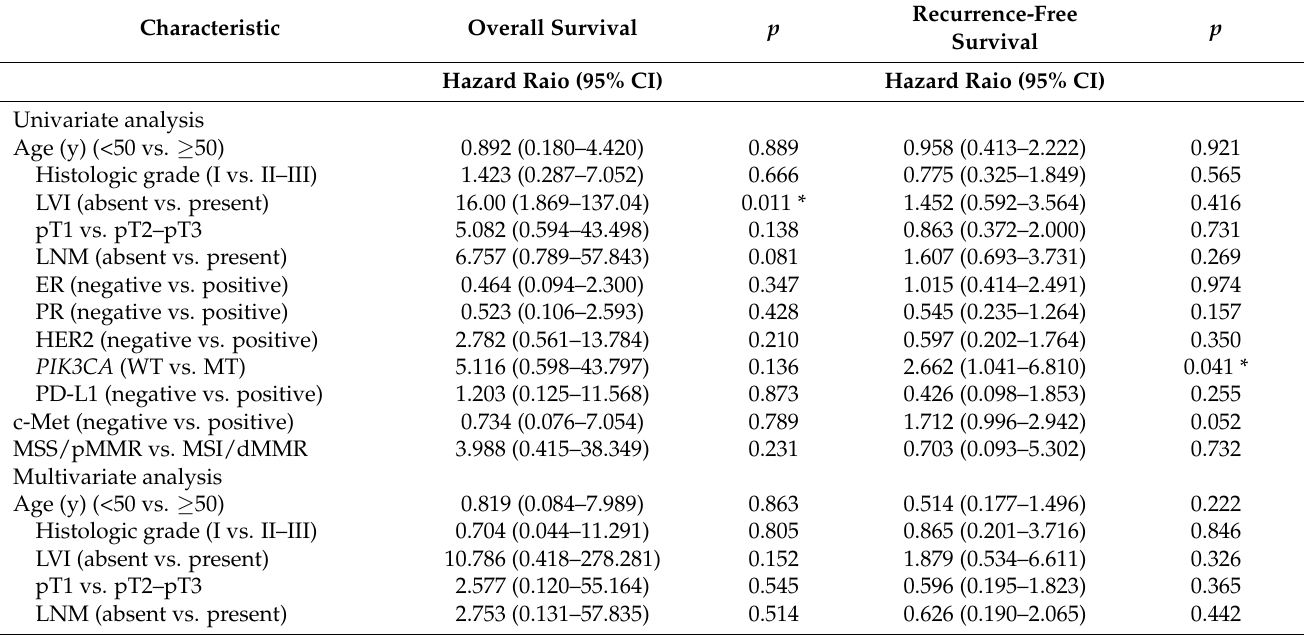
Table 2. Univariate and multivariate analyses of overall survival and recurrence-free survival of patients with breast cancers.